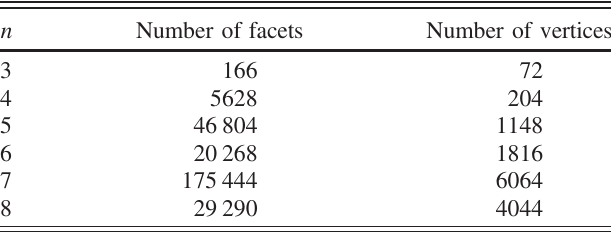
TABLE I. Number of tight Bell inequalities (facets) and number of extremal points (vertices) of the local polytope projected onto the space of TI, n party, up to R -range correlators [cf. Eq. (53)].